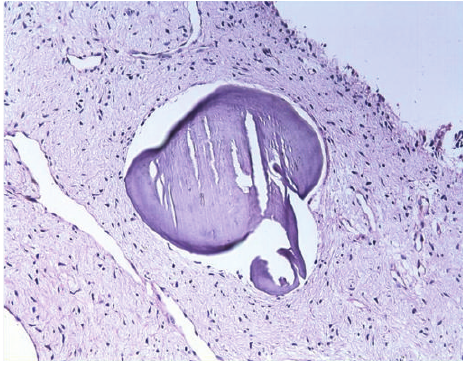
Figure 5: Calcification (PAS × 40).